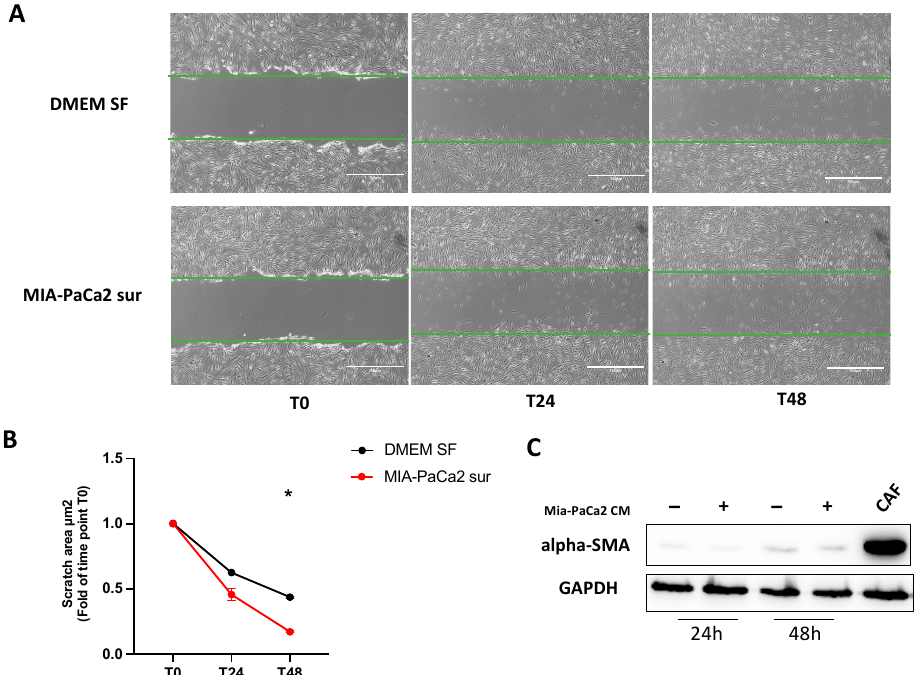
Figure 7. Increased migration in HDF cells treated with MIA-PaCa-2 CM. ( A ) Representative images of scratch assay at different time points (T0, T24 and T48). The scratch is highlighted in green. Scale bar, 750 µm. The wound closure area was calculated with ImageJ software. ( B ) Relative scratch area closure normalized to time T0 scratch. Data represent the means ± SD of two independent experiments. Symbol indicates significant difference between DMEM SF and treated cells (* p < 0.05). ( C ) Western blot analysis of alpha-SMA expression after 24 and 48 h of treatment compared to CAFs as positive control.